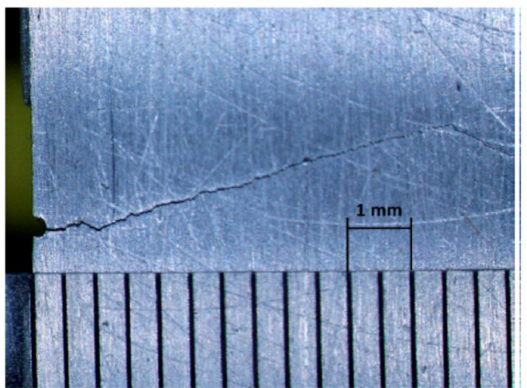
Figure 16. Fatigue crack close-up in one of the aluminum beam components.